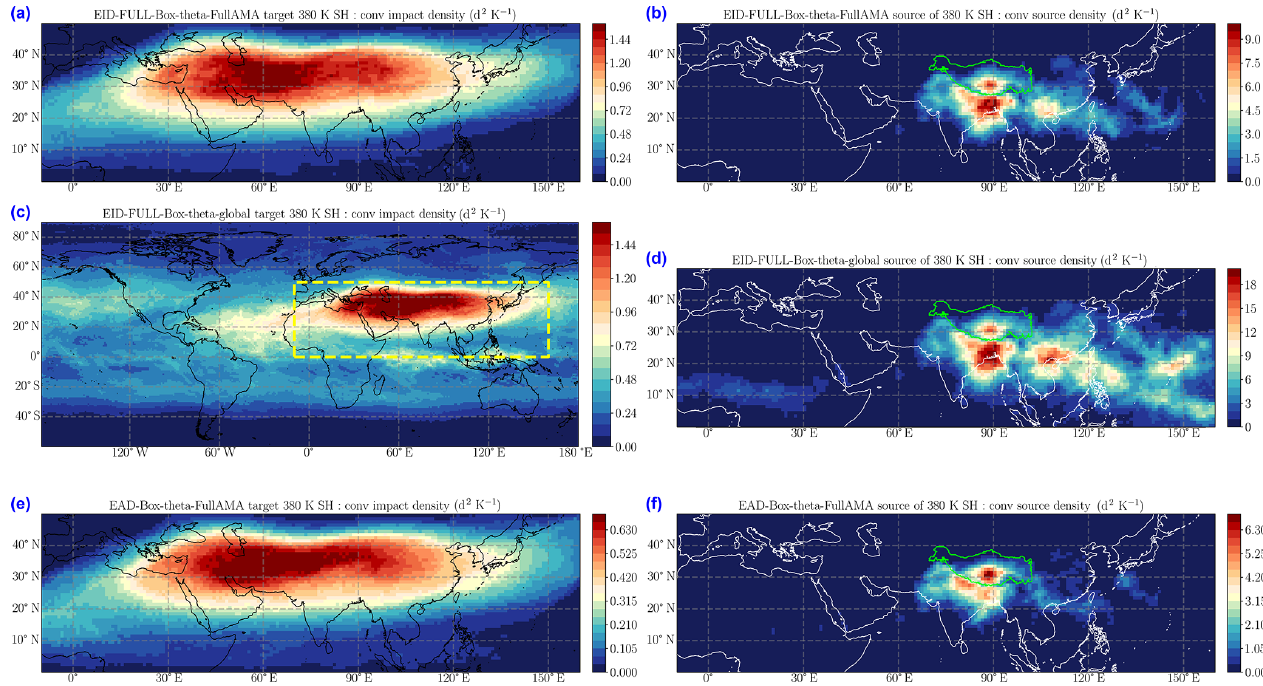
Figure 2. Impact density and source density for the convective parcels reaching the 380K target level, accumulated over the 1 June–31 August 2017 launch interval and the 2-month lifetime of the parcels. Left column (a, c, e) : the impact density at the 380K target level. Right column (b, d, f) : the source density of convective clouds from which the parcels reaching 380K were launched. Upper row (a, b) : ERA-Interim diabatic trajectories in the FullAMA domain. Mid-row (c, d) : ERA-Interim diabatic trajectories in the global domain. Lower row (e, f) : ERA5 diabatic trajectories in the FullAMA domain. The green contour on the right panels (b, d, f) shows the Tibetan